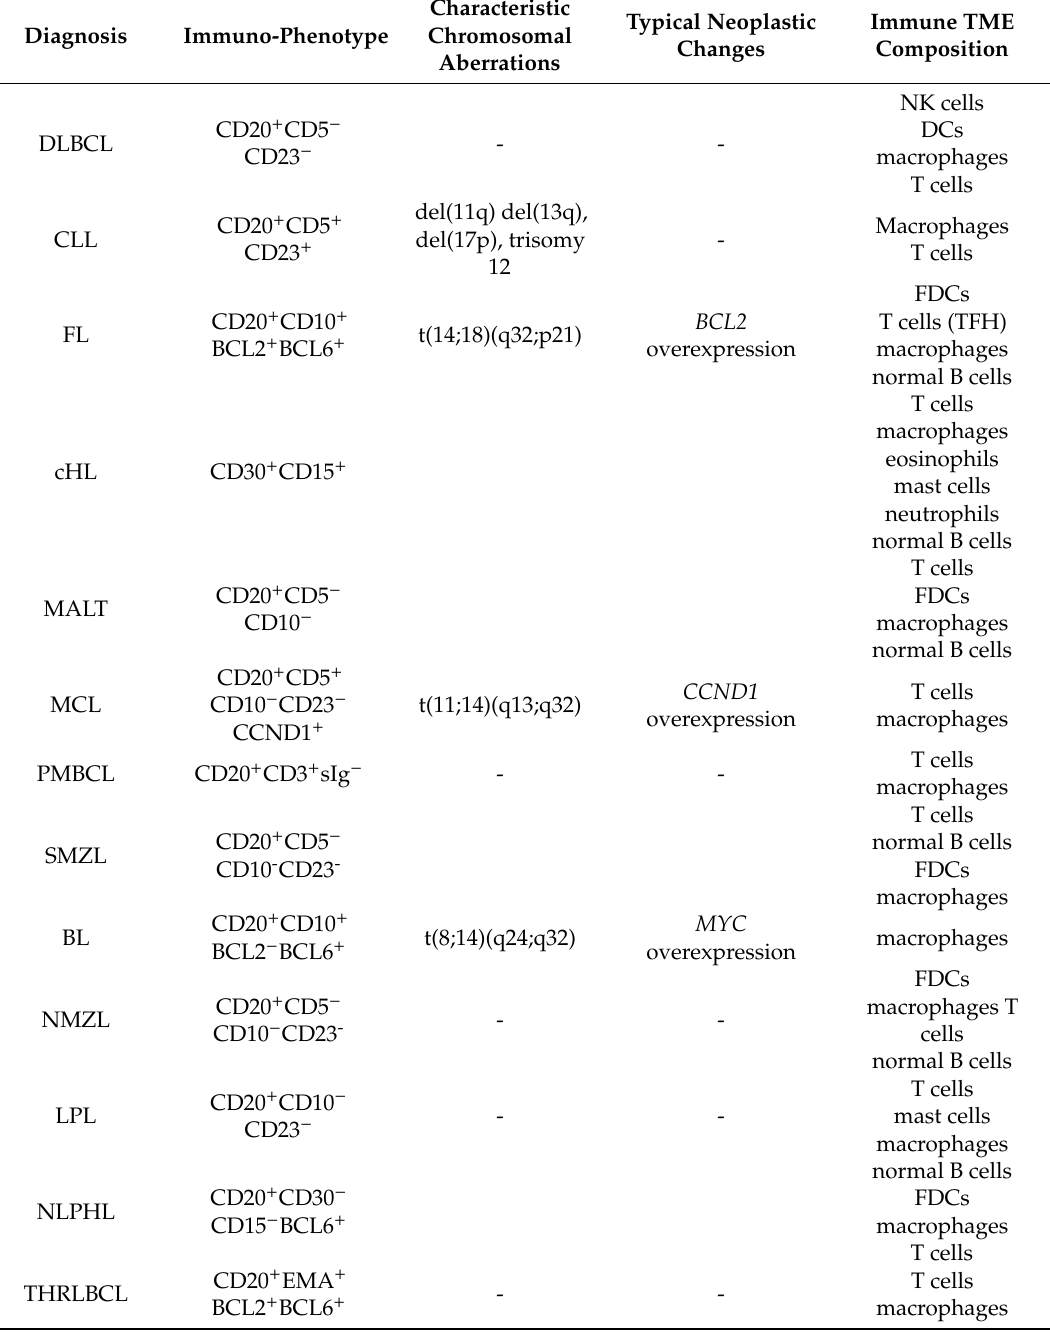
Table 1. Key pathological features of lymphomas of B-cell